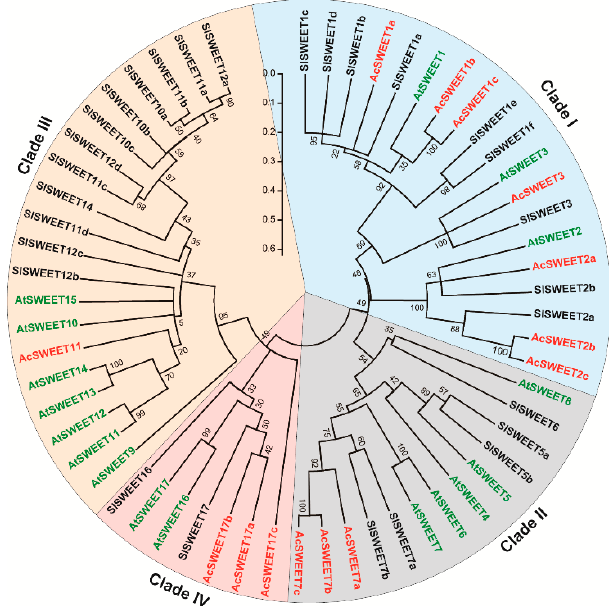
Figure 6. Phylogenetic tree of amino acid sequences of SWEETs among A. chinensis and other species. The trees were constructed by the neighbor-joining method based on amino acid differences (p-distance) using the MEGA 7.0 program with complete deletion and 1000 bootstrap replicates. Accession numbers or gene ID (Table S1).